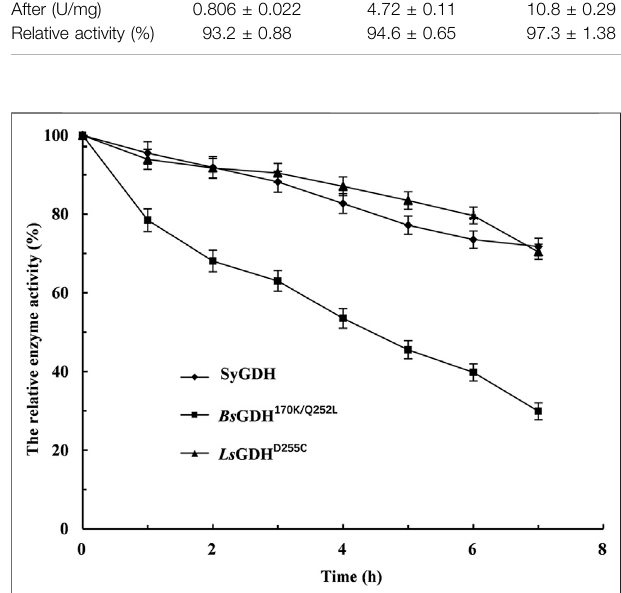
FIGURE.4| Effectofthetimeofheattreatmentonthestabilityofglucose dehydrogenasesundertheoptimalcatalyticconditionsof40 ° CandpH5.0. ◆ , the cell lysate of induced E. coli/ Sy gdh ; ■ , the cell lysate of induced E. coli/ Bsgdh 170k/Q252L ; ▲ ,thecelllysateofinduced E.coli/Lsgdh D255C .Means and standard deviations of triplicate experiments are